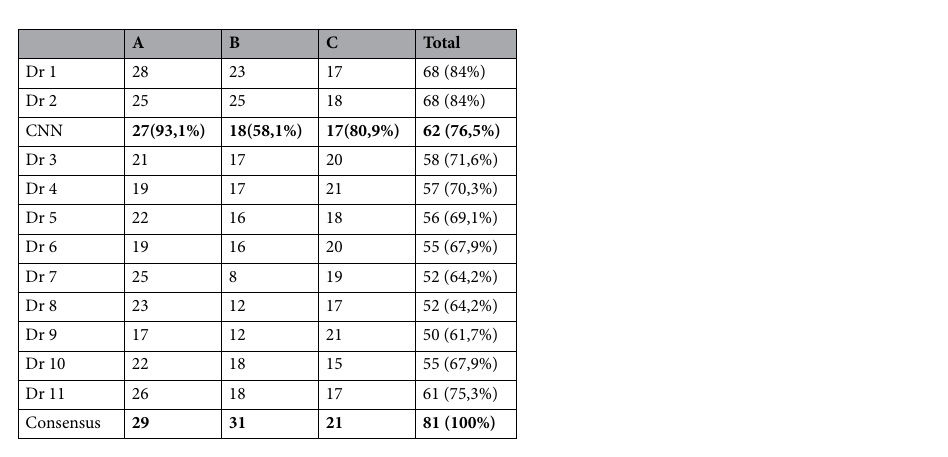
Table 5. Quantitative evaluation of all assessors and CNN. Significant values are in